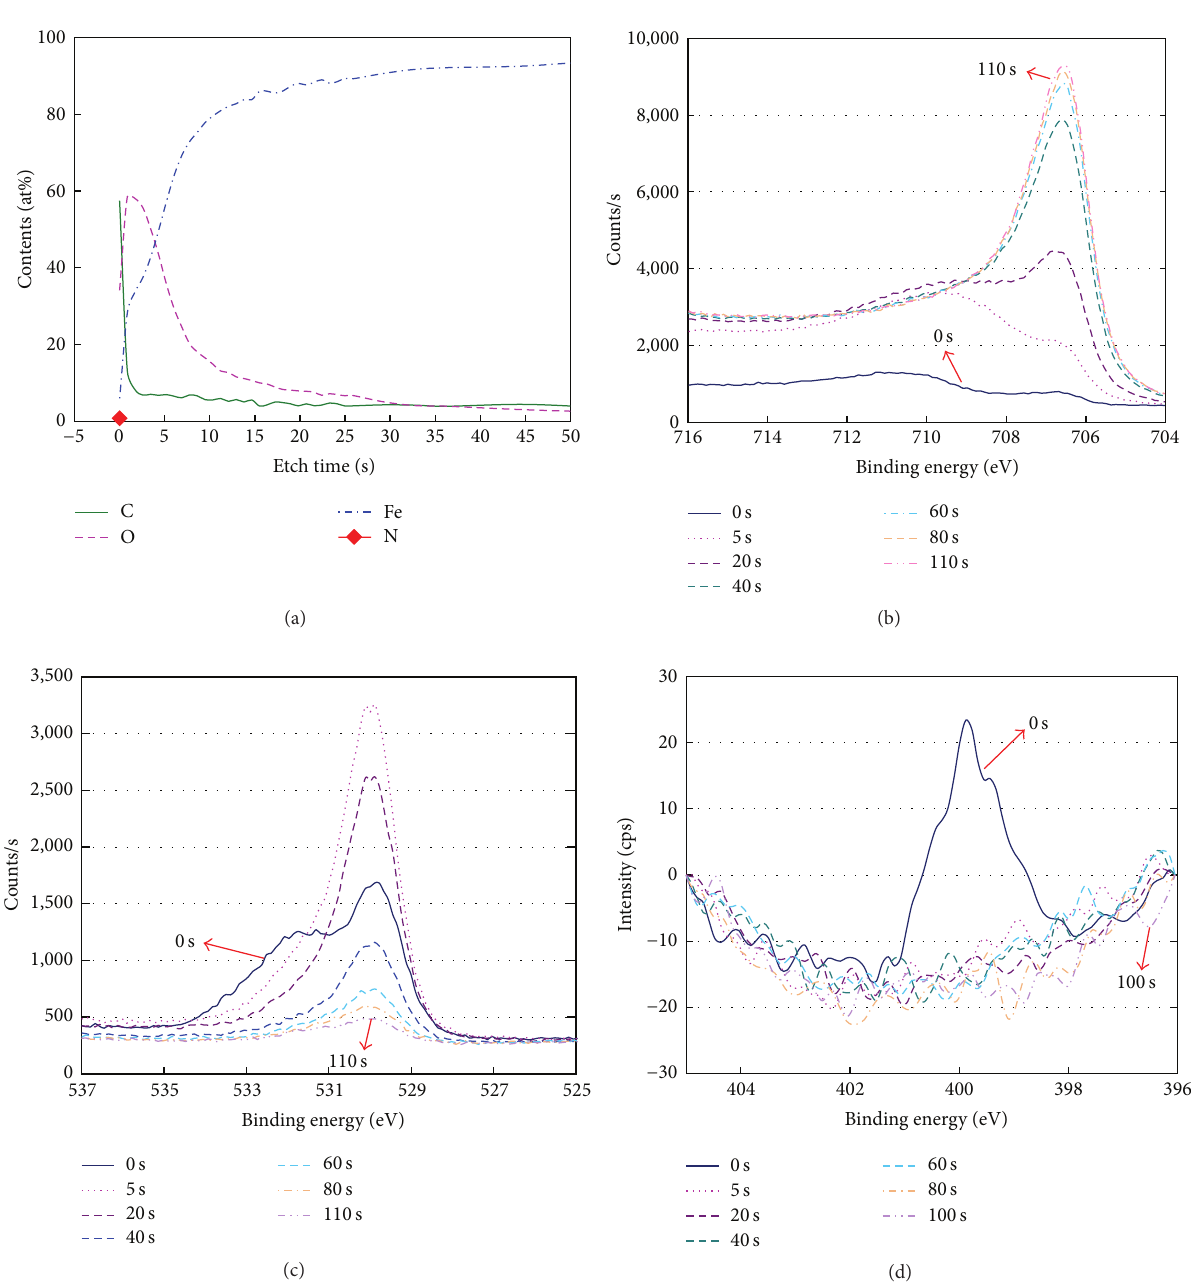
Figure 12: Depth profile by XPS on passive film of carbon steel passivated for 24 hours in simulated cooling water (1,000 ppm NaNO 2 ) at 25 ∘ C; (a) depth profile, (b) Fe 2 p detail scan, (c) O 1 s detail scan, and (d) N 1 s detail